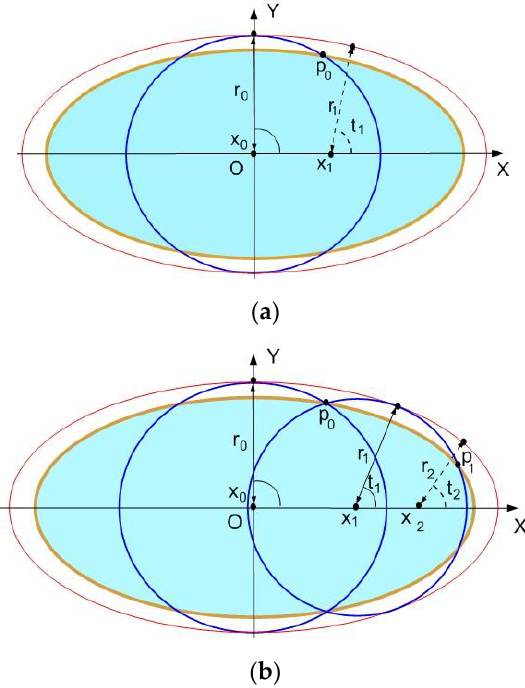
Figure 2. Illustrations of the first and the second iterations of the algorithm for Stage 1: ( a ) the first iteration; ( b ) the second iteration. Appl. Sci. 2020 , 10 , x FOR PEER REVIEW